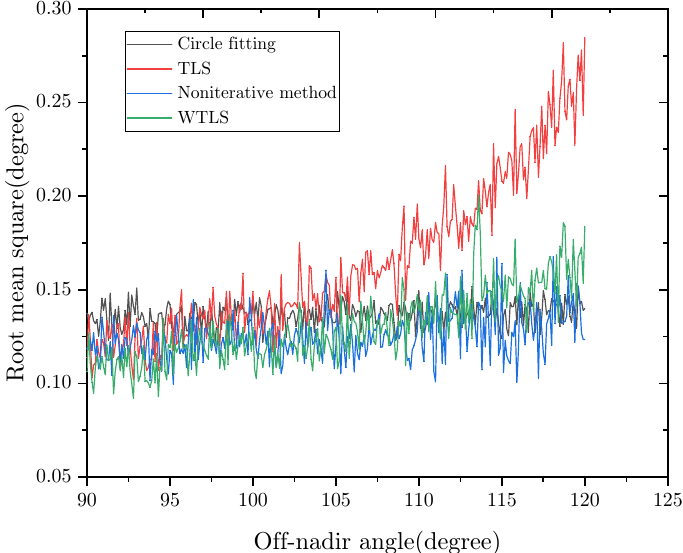
Figure 8. RMS error of the nadir vector vs. off-nadir angle. Off-nadir angle = 90–120 ◦